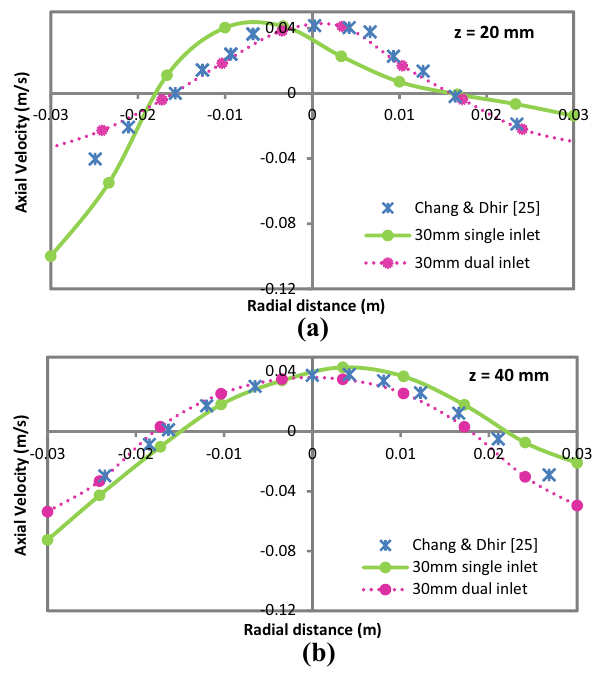
Fig. 5 Validation of axial velocity profile: a z = 20 mm and b z = 40 mm